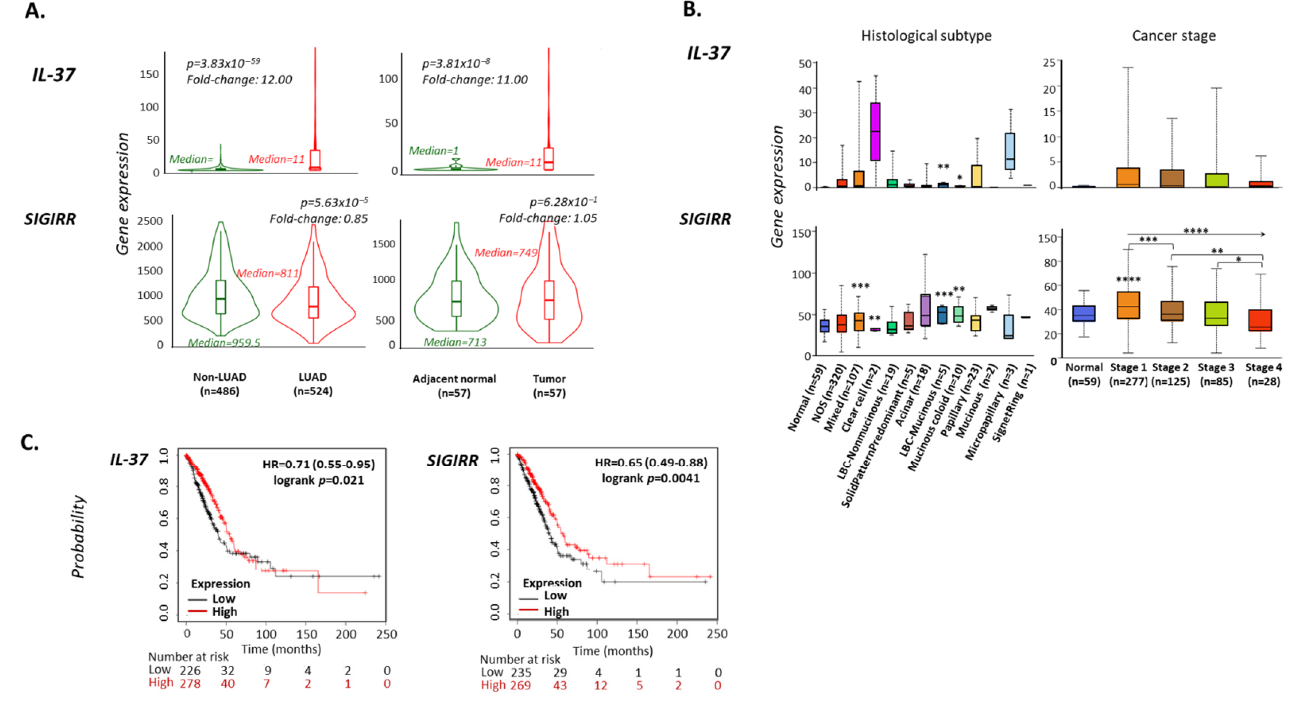
Figure 2. ( A ) Violin plots depicting the differential expression levels of IL-37 and SIGIRR in lung tissues from LUAD (n = 486) vs. non-LUAD (n = 524) individuals or paired tumor vs. adjacent normal tissues from LUAD patients (n = 57 pairs). Median expression levels, Mann–Whitney p -values, and fold-changes between medians are reported. Data were obtained from www.tnmplot.com [32] (accessed on 3 September 2022). ( B ) Box and Tukey whiskers diagrams showing the differential distribution of IL-37 and SIGIRR expression levels (FPKMs) as analyzed by RNA sequencing in LUAD samples of different histological type or stage. Data were obtained from http://ualcan.path.uab.edu/ (accessed on 20 September 2022). Asterisks designate statistically significant differences compared to normal samples; between groups (where accompanied by brackets) as analyzed by unpaired t -test with Welch’s correction or statistically significant linear trend between group means and left-to-right order (where accompanied by an arrow) as analyzed by one-way ANOVA test; *: p < 0.05, **: p < 0.01, ***: p < 0.001, ****: p < 0.0001. ( C ) Kaplan–Meier plots depicting the probability of overall survival in months in LUAD patients exhibiting high (red) or low (black) expression levels of IL-37 , SIGIRR . Hazard ratio (HR), logrank p -values, number of patients with either high or low gene expression categorized also in those who survived for 50, 100, 150, 200, and 250 months are reported. Graphs were exported from www.kmplot.com Table 2. Differential distribution of IL-37 and SIGIRR mRNA levels in LUAD vs. non-LUAD tissues or among LUAD tumors of different histological type or stage. Number of patients in each group, the median levels of expression and their range (where available), fold-change over non-LUAD/nor- mal samples, p -values, and the webtool used for the analysis (TNMplot [32], UACLAN [33]) are reported.